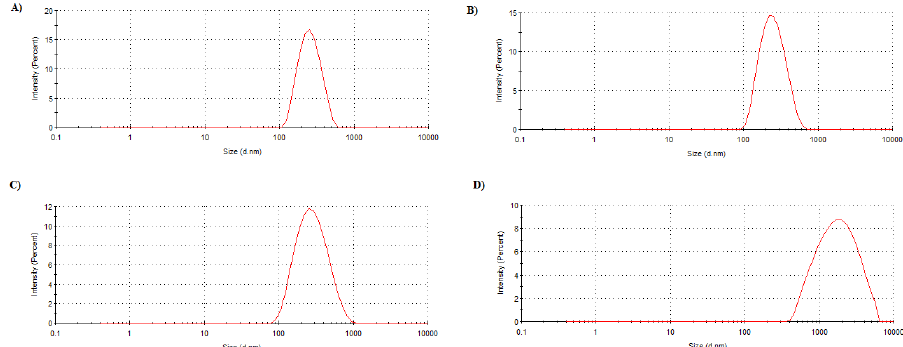
Figure 5. In vitro evaluation of NC and NC-CH mucoadhesiveness. Distribution of hydrodynamic diameter for ( A ) NC; ( B ) NC mixed with mucin nanoparticles; ( C ) NC-CH; ( D ) NC-CH mixed with mucin nanoparticles.